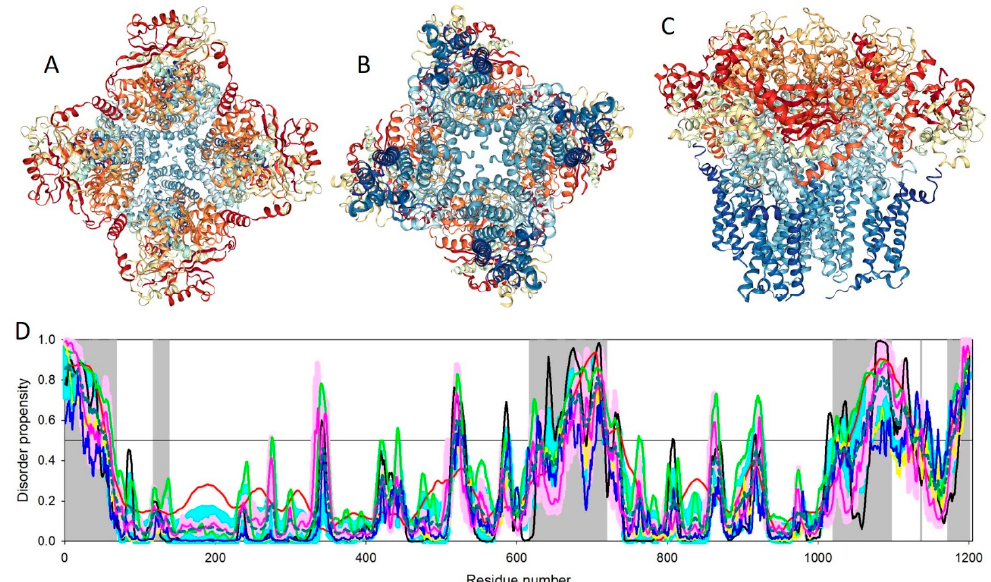
Figure 6. Three projections of the 3D structure of the homo-tetrameric Slo2.2 Na + -activated K + channel (chicken KCNT1) resolved by single-particle cryo-EM (PDB ID: 5U70, [144]): ( A ). Cytoplasm view; ( B ). Membrane view; and ( C ). Side view. ( D ). Evaluation of the intrinsic disorder propensity of the chicken KCNT1 (UniProt ID: Q8QFV0) by a set of commonly used disorder predictors. Presented disorder profiles were generated by PONDR-FIT (pink curve), PONDR ® VLXT (black curve), PONDR ® VSL2 (green curve), and PONDR ® VL3 (red curve) [106–111], as well as two tools from the IUPred web server for predicting short and long disordered regions (blue and yellow curves, respectively) [112]. The dark cyan dashed line shows the mean disorder propensity calculated by averaging the disorder profiles of the individual predictors. The light pink shadow around the PONDR ®